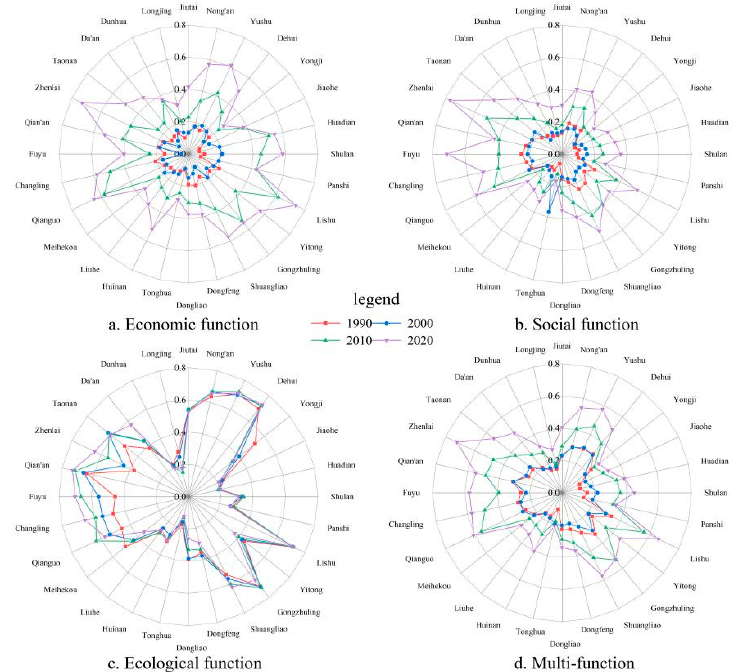
Figure 3. Multi-functional composition of cultivated land in 28 black-soil breadbaskets, Jilin Province, Northeast China, from 1990 to 2020. ( a ) Economic function. ( b ) Social function. ( c ) Ecological function. ( d ) Multi-function.